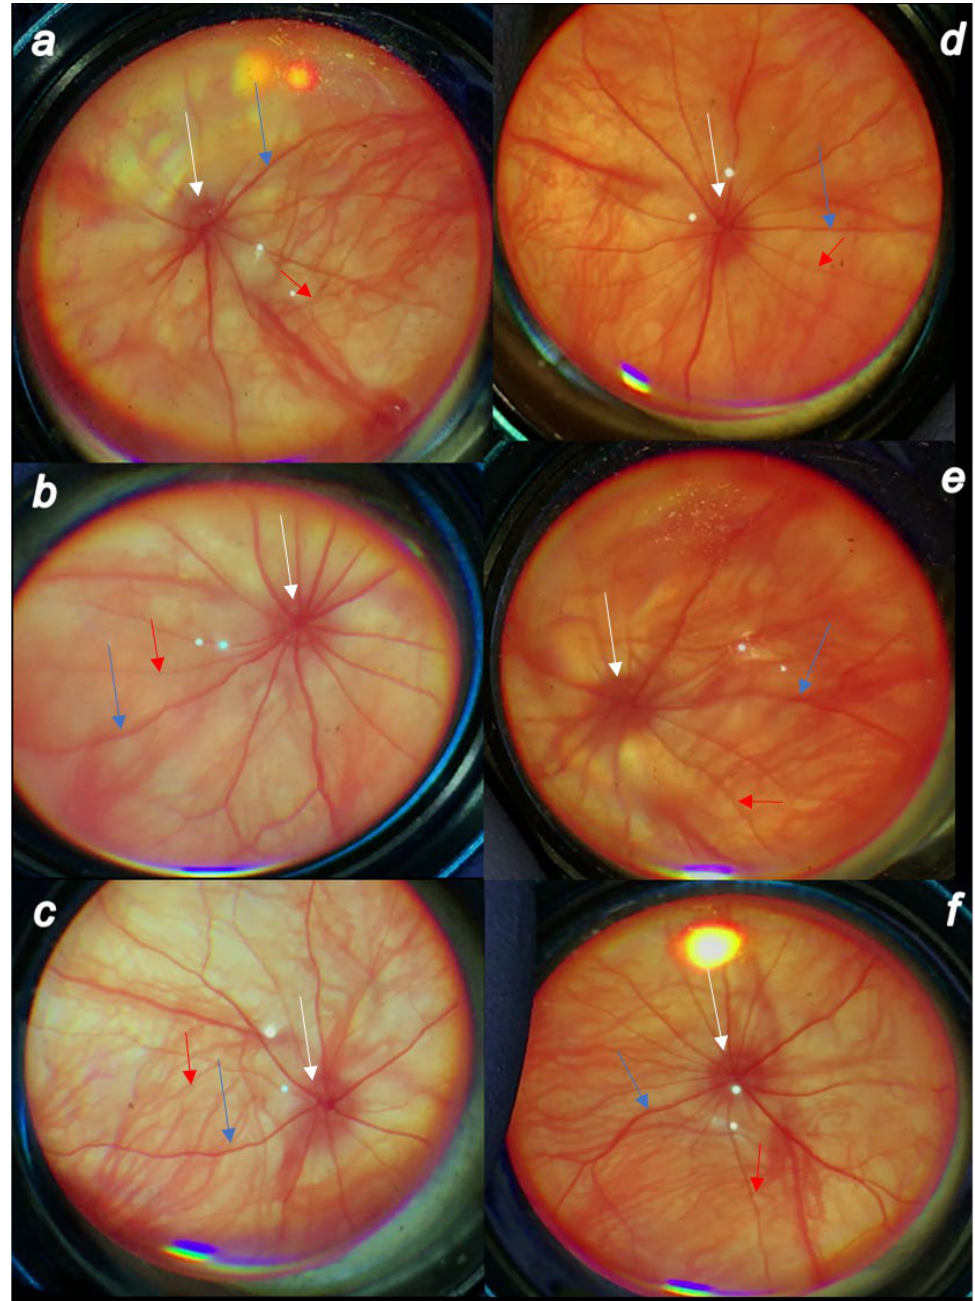
Figure 5. Cauterization of the three episcleral veins induced posterior eye segment changes (veins (blue arrows), arteries (red arrows), optic disc (white arrows)) assessed by fundoscopy. Prophylactic regimen. ( a ) First post-injury day, regular course. ( b ) Fourth post-operative week, regular course. ( c ) Sixth post-injury week, regular course. ( d ) First post-injury day, course in BPC 157-treated rats. ( b